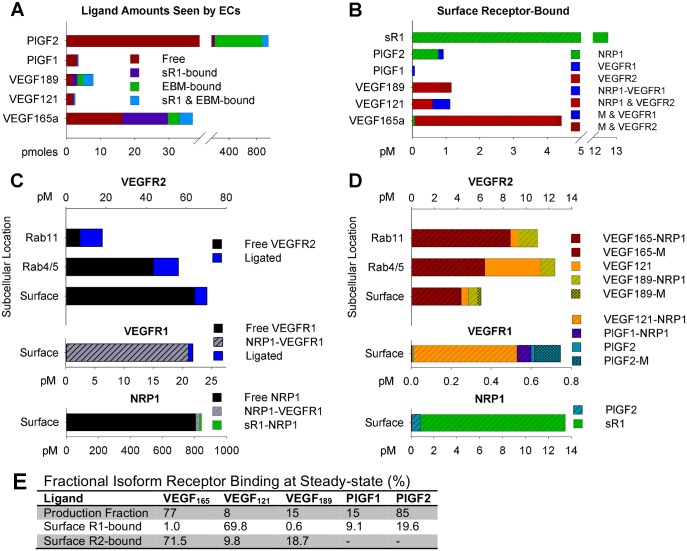
Pharmacodynamics of ligand binding to VEGFR1 and VEGFR2.(A) Total soluble growth factor (in available interstitial fluid) and immobilized growth factor (in innermost 25nm of EBM) accessible to ECs. Growth factor bound to EC receptors is not included in this plot. (B) Break-down of EC surface-bound ligand, by isoform. Note the difference in quantities of total ligated VEGFR2, VEGFR1, and NRP1 (panel C). (C) Occupancy of VEGFR2, VEGFR1, and NRP1 on ECs, broken down by ligand and NRP1-binding. VEGFR2 occupancy is shown on the cell surface, in early signaling endosomes (Rab4/5), and in recycling endosomes (Rab11), while VEGFR1 and NRP1 are shown only on the cell surface. Quantities are given in pM of total tissue in the “Main Body Mass” compartment. (D) VEGFR2, VEGFR1, and NRP1 ligation on ECs, excluding receptor not bound to ligand. Complexes not listed in the legend are present at levels too low to be seen in the figure. (E) Break-down of percentage of EC surface VEGFR1 and VEGFR2 ligation comprised by each isoform, compared to the relative production of each isoform. Production fractions are calculated separately for VEGF and PlGF, while for receptor binding the combined distribution is shown.